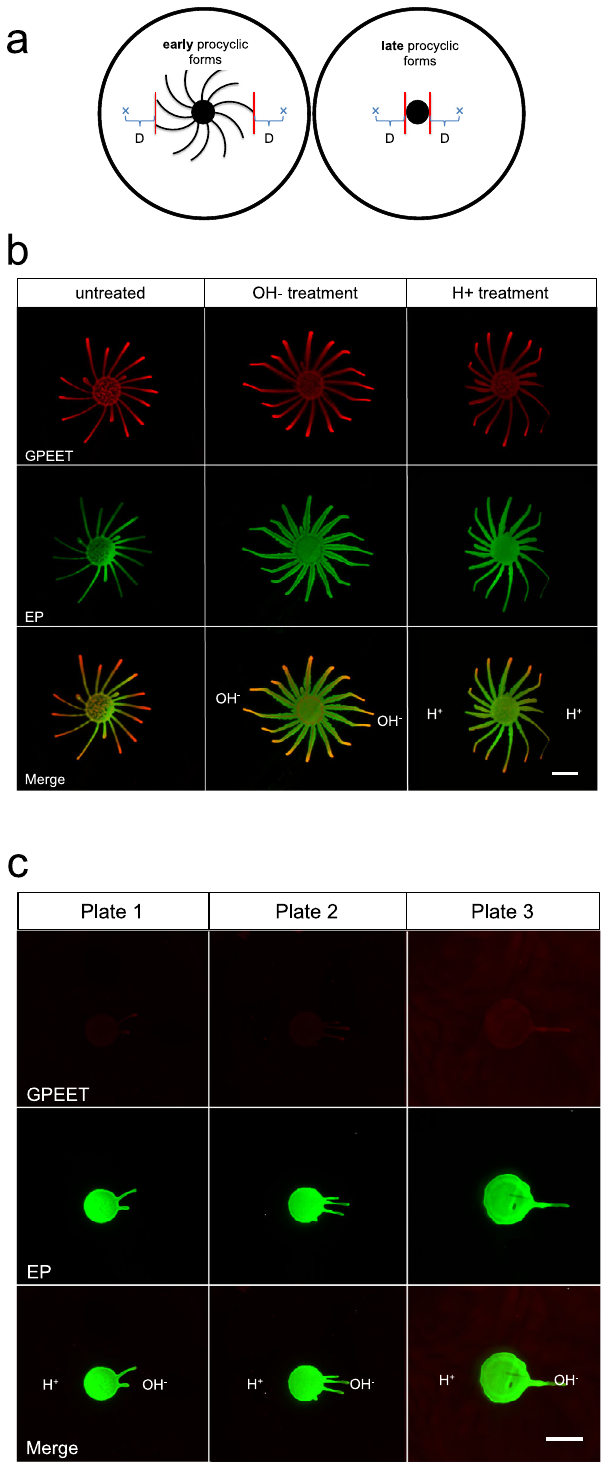
Fig. 3 Response of early and late procyclic forms to acidic or basic solutions. a Schematic representation of the pH taxis assay. “ x ” represents the site where a solution was spotted. “ D ” is the distance between the closest projection and the spot. In these experiments D = 1.3cm. b Early procyclic forms (EATRO1125) on DTM plates were exposed to NaOH (OH − treatment) or HCl (H + treatment) on both sides of the population. c Late procyclic forms were exposed to NaOH on the right side and HCl on the left side of the community. Scale bar: 1 cm. For ( b ) and ( c ) community lifts stained for EP (green) and GPEET (red) are shown. The response of early and late procyclic forms to acidic or basic solutions was tested at least three